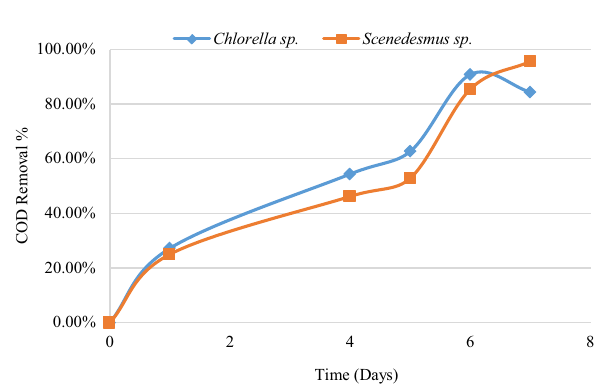
Fig. 5 Phosphate-phosphorous reduction by isolated microalgae strains